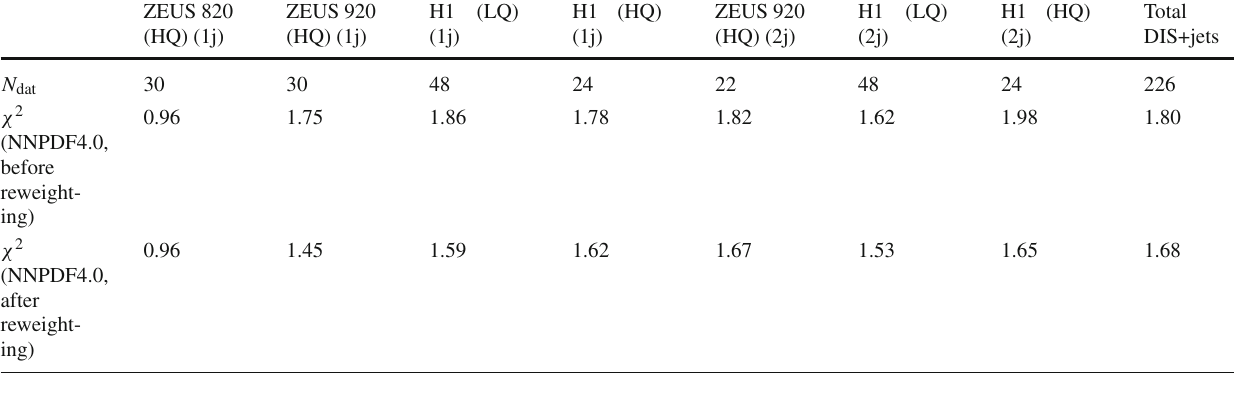
Table 30 The number of data points N dat and the χ 2 value before and after reweighting the NNPDF4.0 baseline PDF set with the full set of DIS jet data (see Sect. 2.2.2 for details). The total χ 2 values are also shown